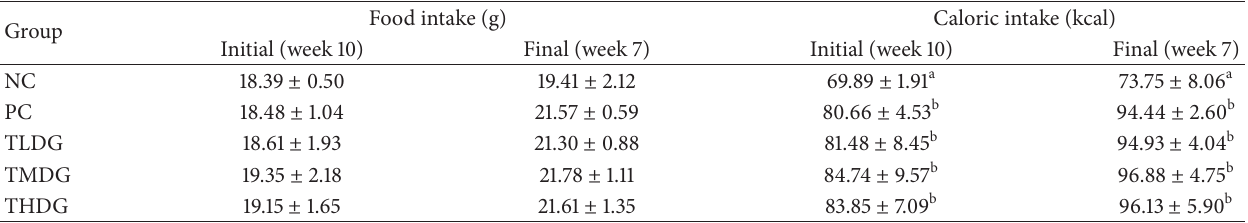
Table 2: Mean of food and caloric intake of rats after the obesity induction week (week 10) and after treatment week (week 7). Food intake (g) Caloric intake (kcal) Group Initial (week 10) NC 18.39 ± 0.50 PC 18.48 ± 1.04